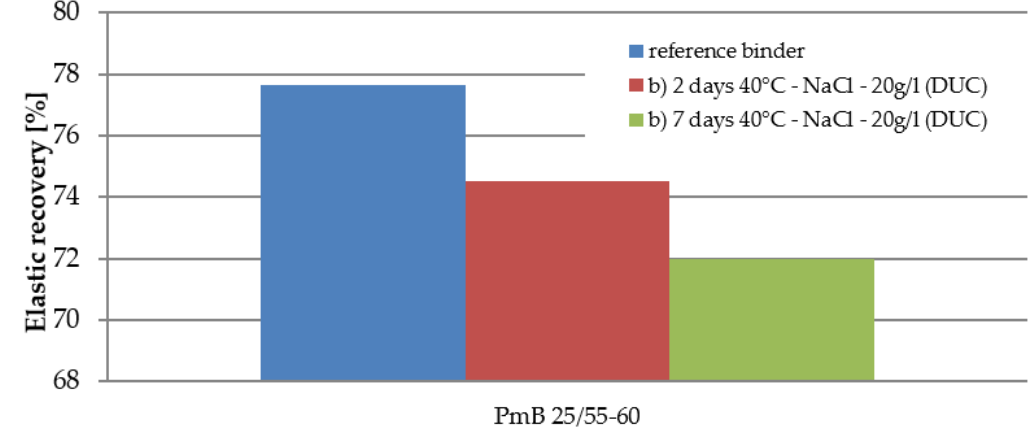
Figure 5. Elastic recovery (%) of the polymer-modified binder by the action of sodium chloride. The softening point results have different behavioral tendencies. Gradually, there is